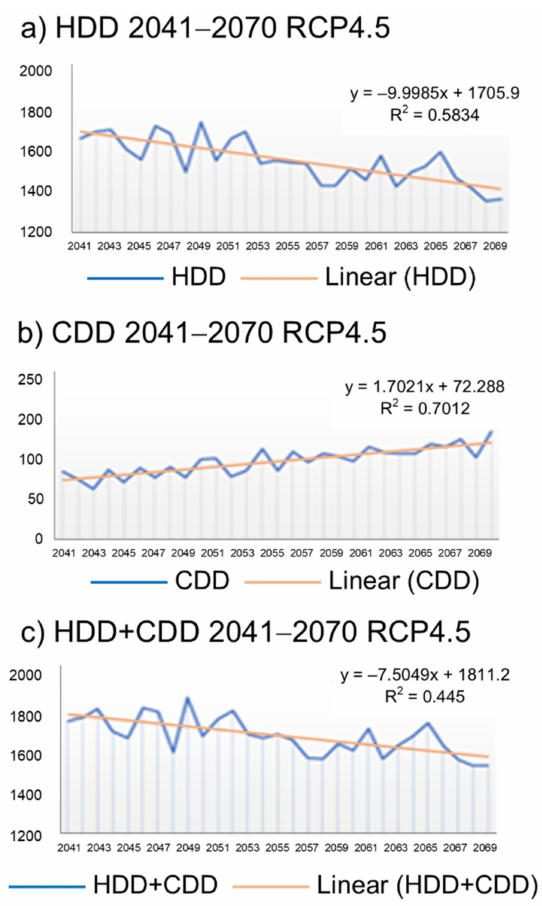
Figure 10. Annual ensemble-mean values of ( a ) HDD, ( b ) CDD, and ( c ) HDD + CDD for Portugal under RCP4.5 between 2041 and 2070 (blue lines) with the respective statistically significant linear trends (linear regression model equation and R 2 coefficient) at a 95% confidence level (orange